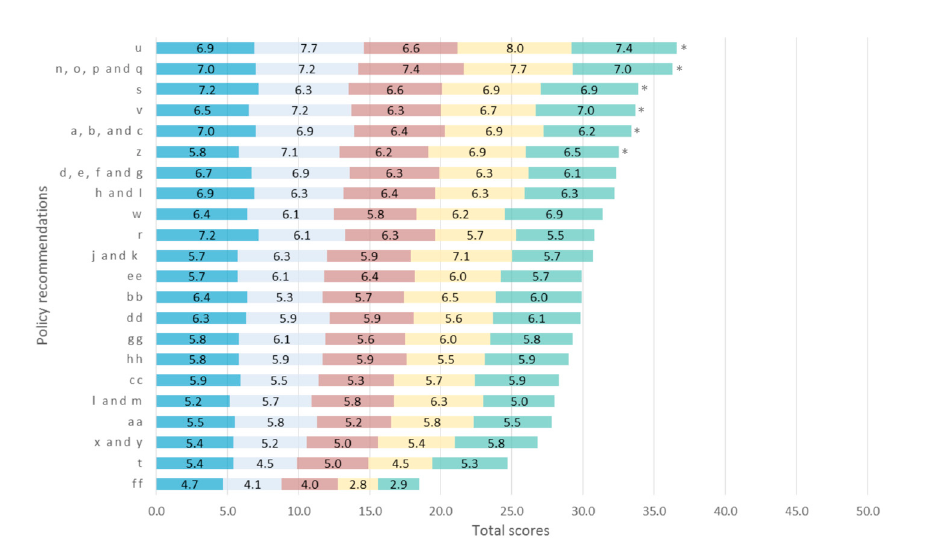
Figure 2. Stakeholder evaluation of policy recommendations based on the five quality criteria ( n = 10). The vertical axis indicates the numbering of policy recommendations as in Table 2. The horizontal axis denotes the score that each (group of) item(s) received. The total scores range from 5 to 50, but the axis is set to start at 0.0 in order to show the correct proportions of ratings for the quality evaluation criteria. The numbers inside the five sections of each bar correspond with the average scores on the criteria. The total scores do not differ significantly among items based on Friedman non-parametric test ( p -value = 0.078). The asterisks (*) indicate the items selected for the Delphi round 2.